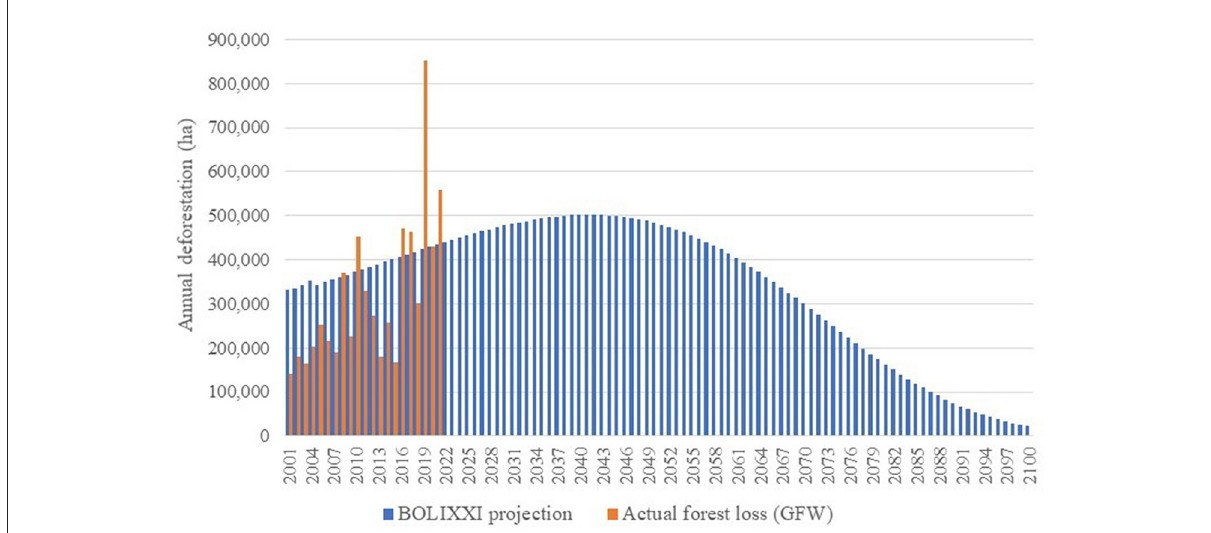
FIGURE1 Actual forest loss vs. BOLIXXI projected forest loss in Bolivia, 2001-2021-2100. Source: Authors’ elaboration based on data from Global Forest Watch and projections from Andersen and Jemio (2015).